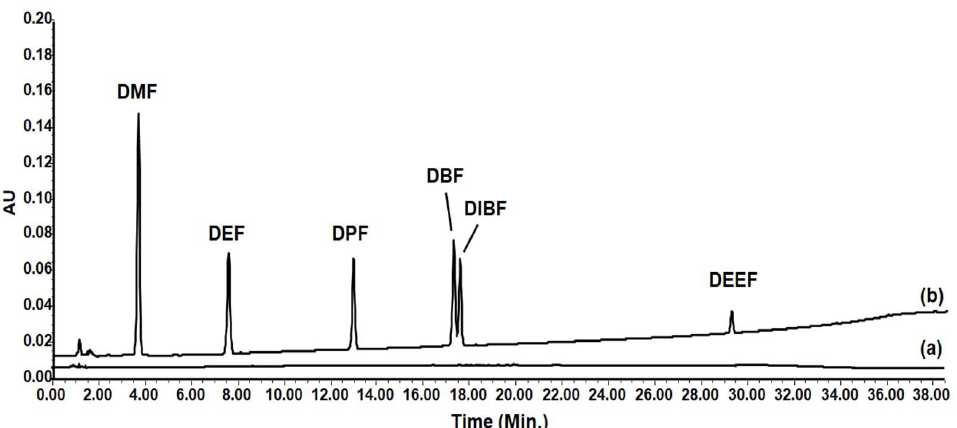
Figure 6. HPLC-PDA chromatograms of blank extract (a) and blank spiked extract (b) with the investigated phthalates at the concentration of 0.75 µg/mL.